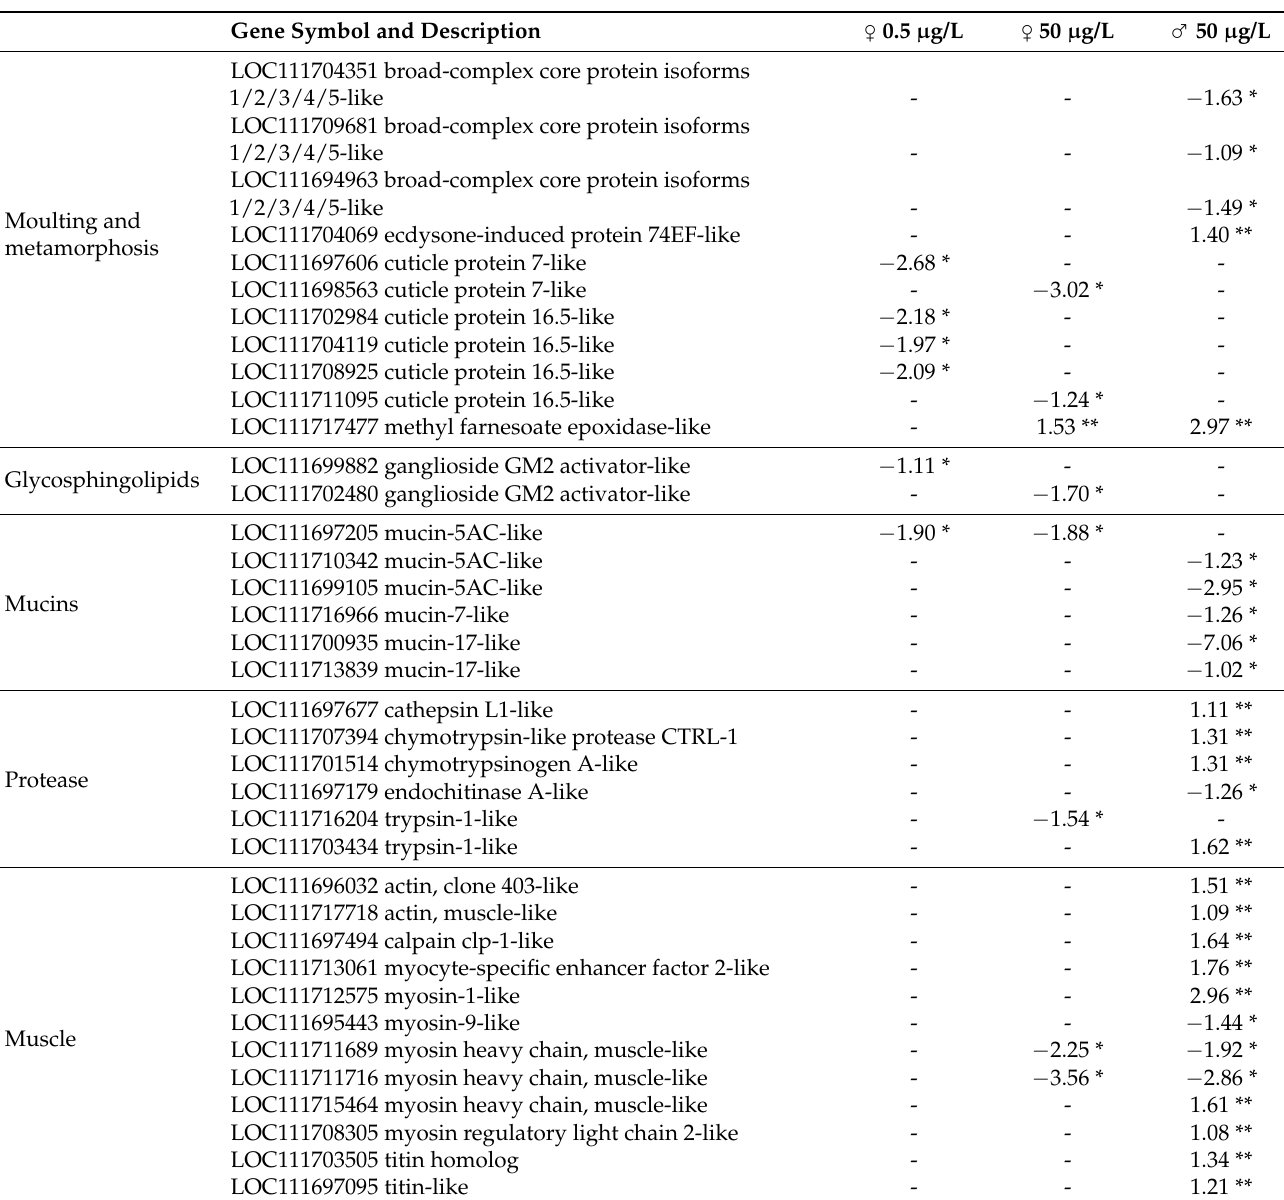
Table 2. Differentially expressed genes (DEGs) of interest after exposure to TEB at 0.5 and 50 µ g/L in adult females and males of E. affinis . Gene symbols and descriptions were retrieved from the NCBI database and sorted by main biological functions. * and ** respective down- and up- regulated genes with their log2FoldChange. Only significant DEGs are represented; if not significant, cells were